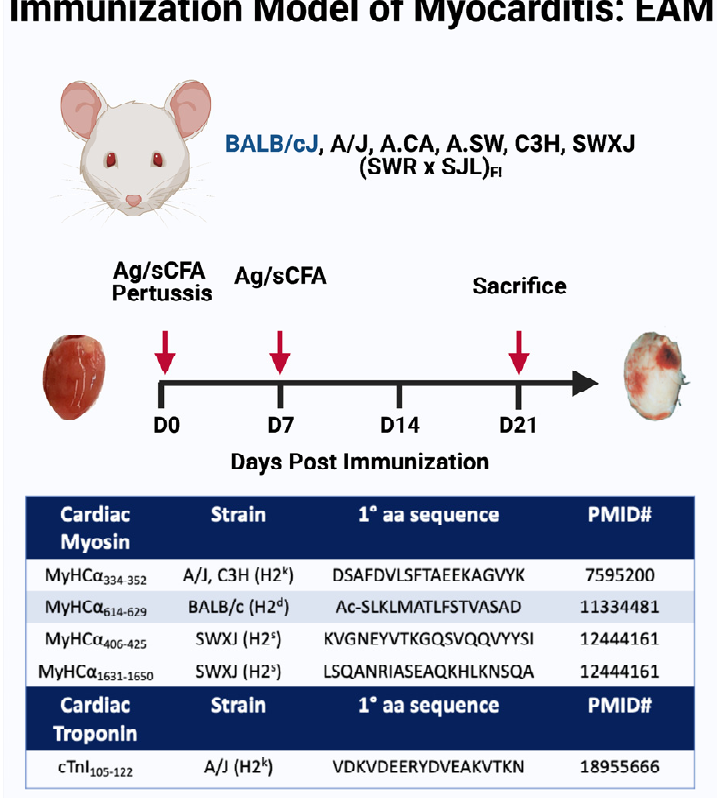
Figure 2. Experimental autoimmune myocarditis murine model. In the EAM model, cardiac myosin or the relevant peptide in Freund’s complete adjuvant is injected subcutaneously into mice on day 0 and day 7. The immune response, the histological changes, and the genetic susceptibility observed in EAM are similar to giant cell myocarditis. #: The numbers are identifying the epitope of myosin heavy chain (MYHC) used for the induction of